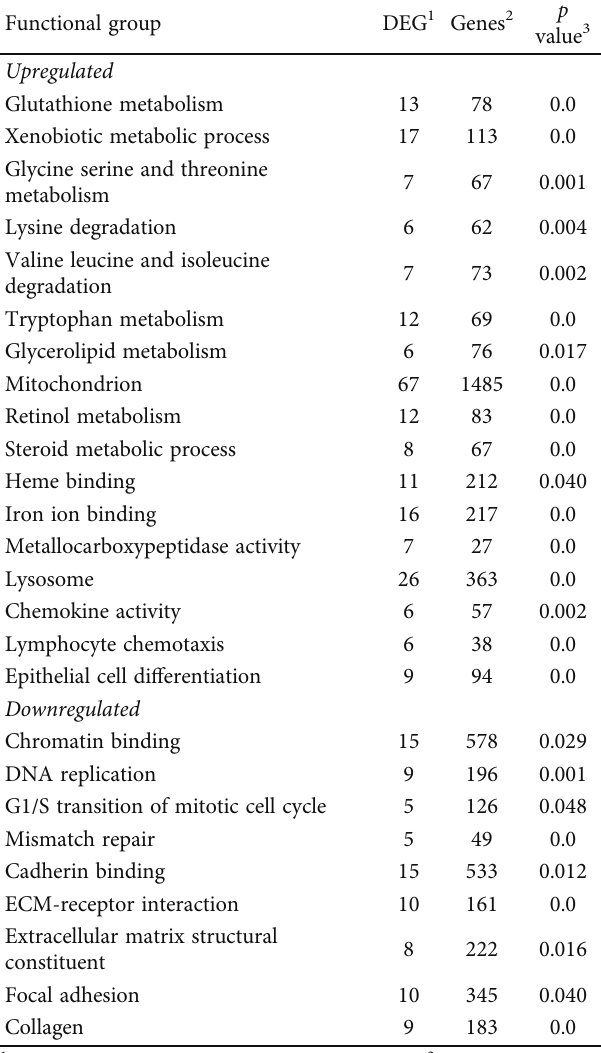
Table 10: Enrichment of functional categories of Gene Ontology among genes that showed an association between expression pro fi les and FM level (diets with supplements were not included in analysis).